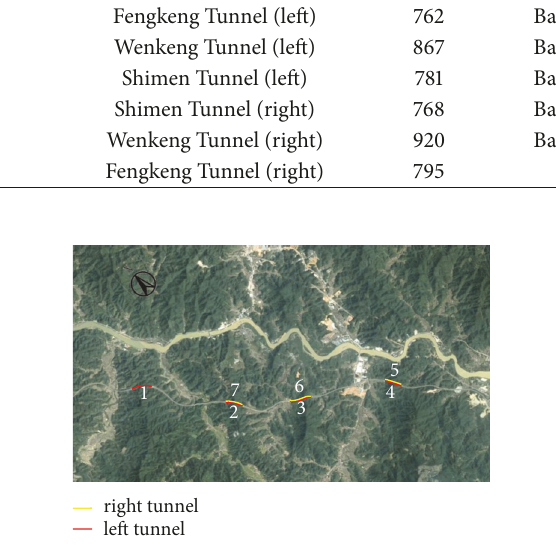
Figure 2: Selected test tunnels along the No. G55 expressway, Guangdong,